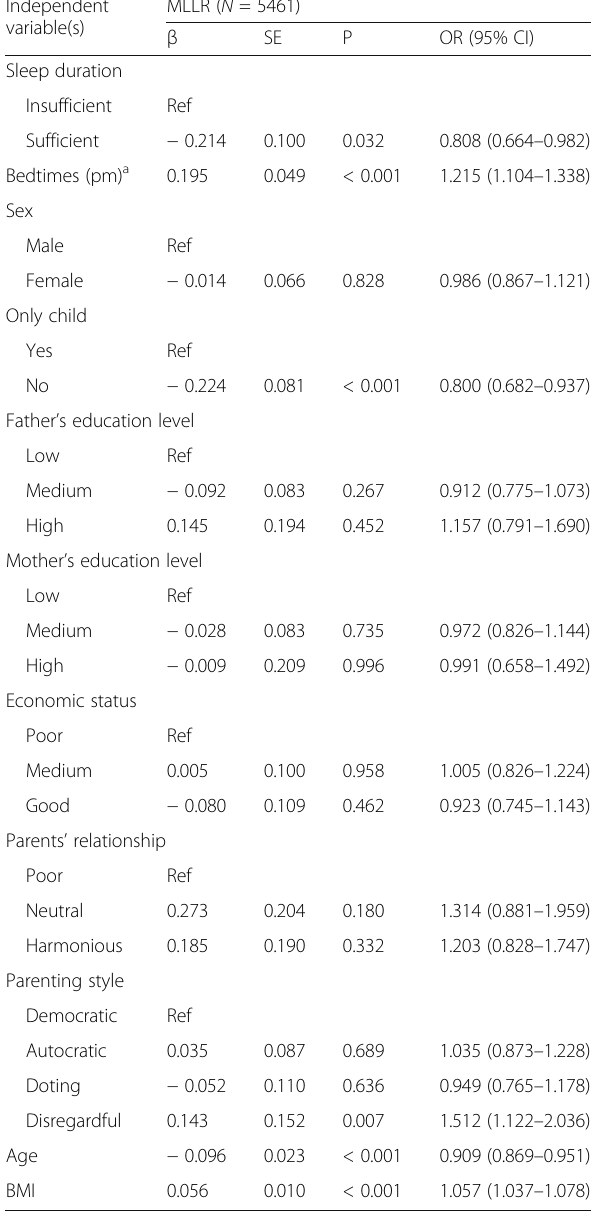
Table 4 Standardized coefficients obtained from multiple logistic linear regression